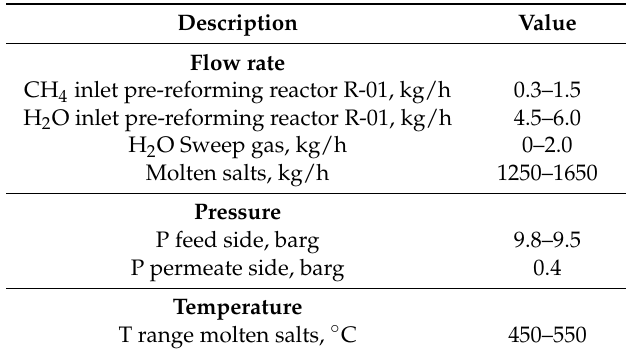
Table 2. Main operating conditions for the integrated membrane reactor.